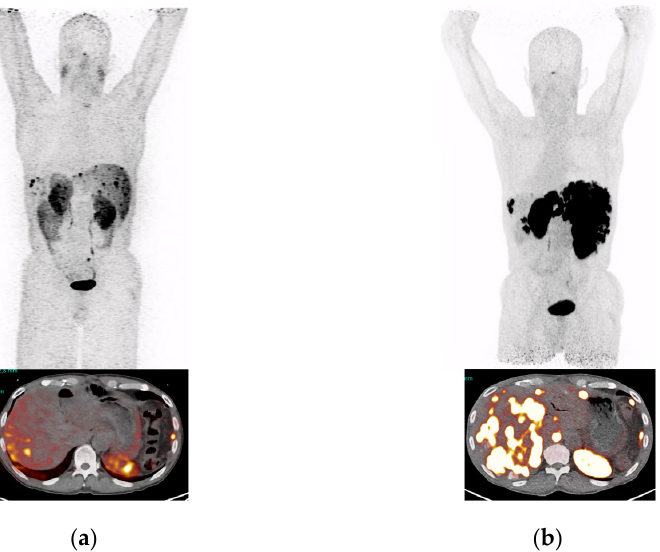
Figure 5. MIPs and transversal images of a patient with pancreatic NET, presenting hepatic and peri- toneal lesions 1 h after intravenous injection of the radioligand. ( a ) [ 64 Cu]Cu-DOTA-TATE PET/CT, ( b ) [ 68 Ga]Ga-DATA 5m -LM4 PET/CT of the patient having received several treatments including several cycles of PRRT with [ 177 Lu]Lu-DOTA-TATE, but remaining with progressive